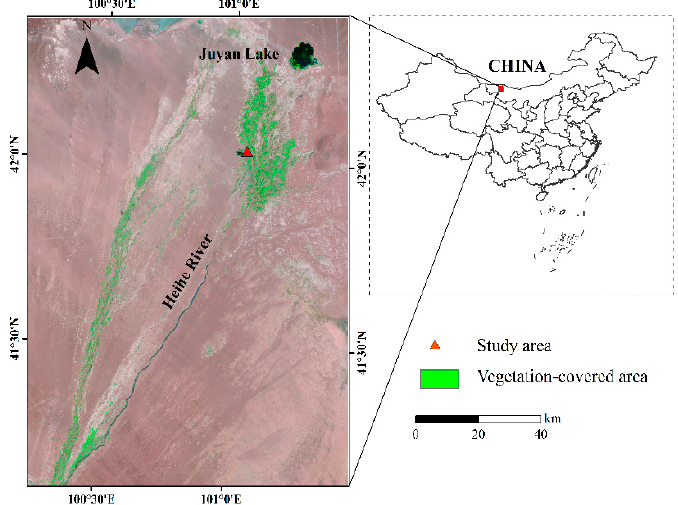
Figure 1. Remote sensing images of downstream oases in the Heihe River Basin in the arid inland region of China.